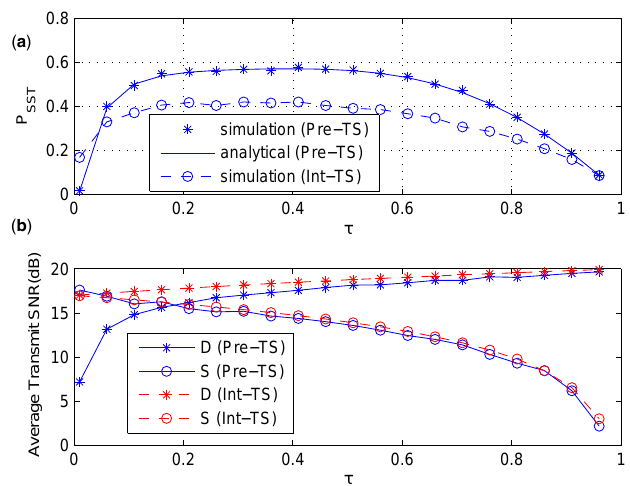
Figure 8. ( a ) P SST under various τ . ( b ) The average transmit SNR under various τ .